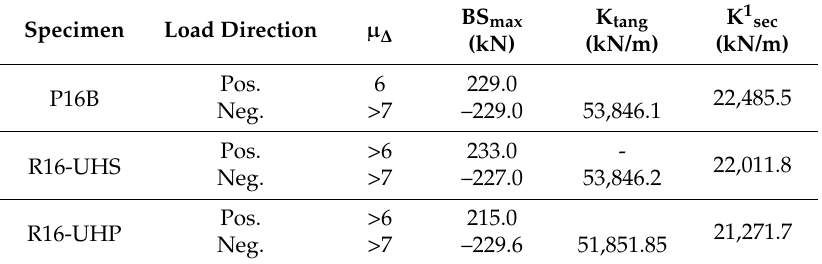
Table 5. Experimental results: Displacement ductility ( µ ∆ ), maximum base shear (BS max ), and tangent stiffness (K tang ) in a negative direction; secant stiffness (K 1 sec ) for the first cycle of Tol as part of the displacement history (Figure